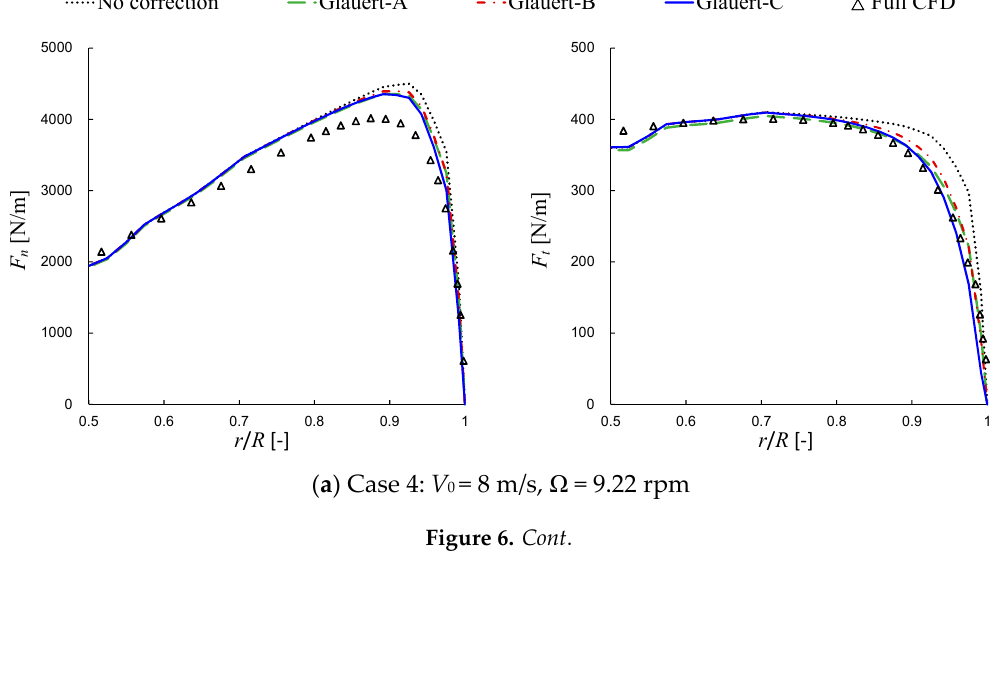
△ Full CFD Figure 6. Cont